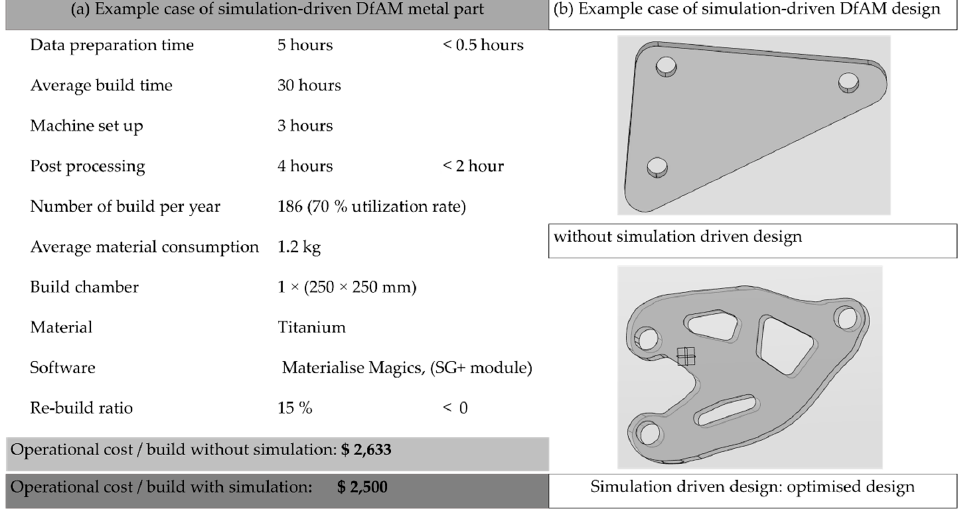
Figure 9. Example of ( a ) production cost reduction and ( b ) optimized design using a simulation-driven preventive method. Data in ( a ) from [9].